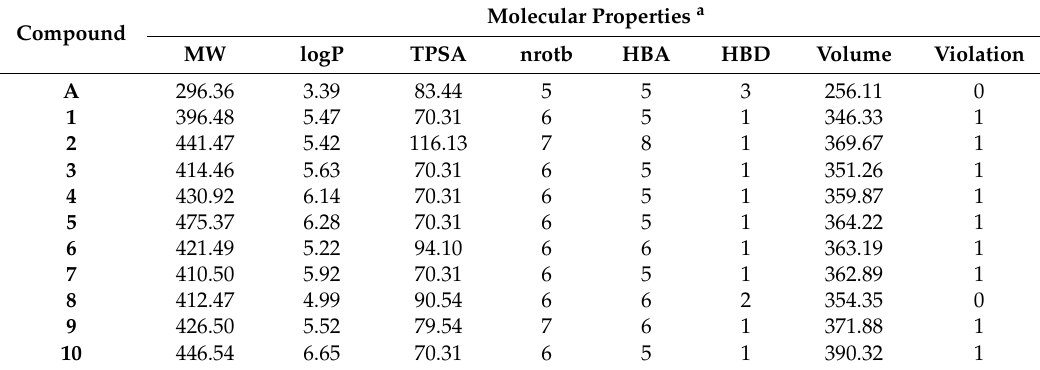
Molecular Properties